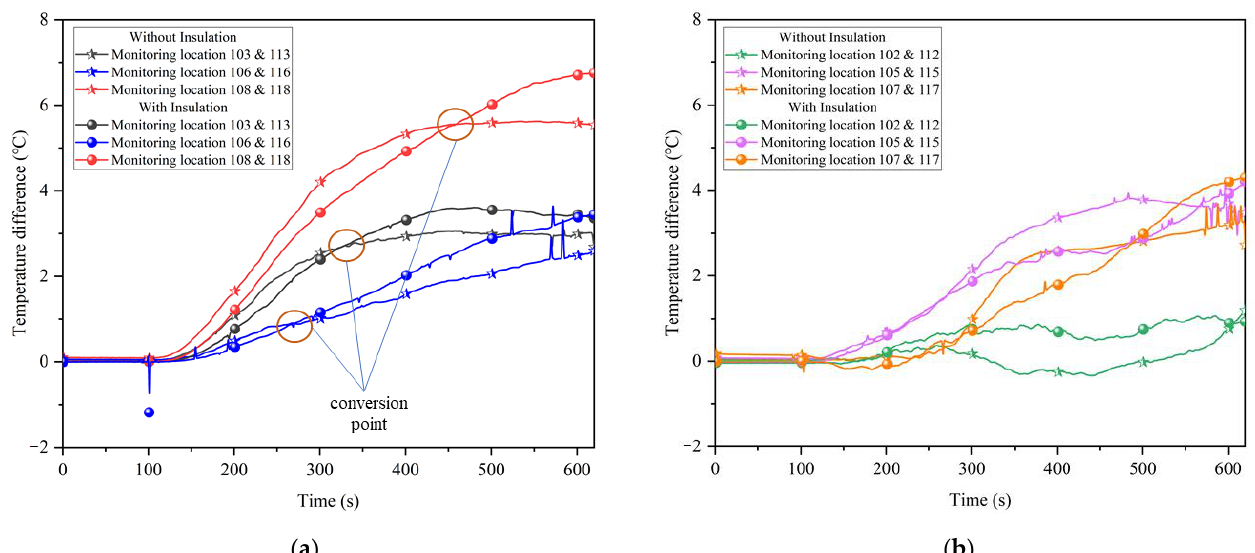
Figure 6. Temperature difference between vertical sections at selected monitoring locations: ( a ) Left side of tunnel; ( b ) Middle of